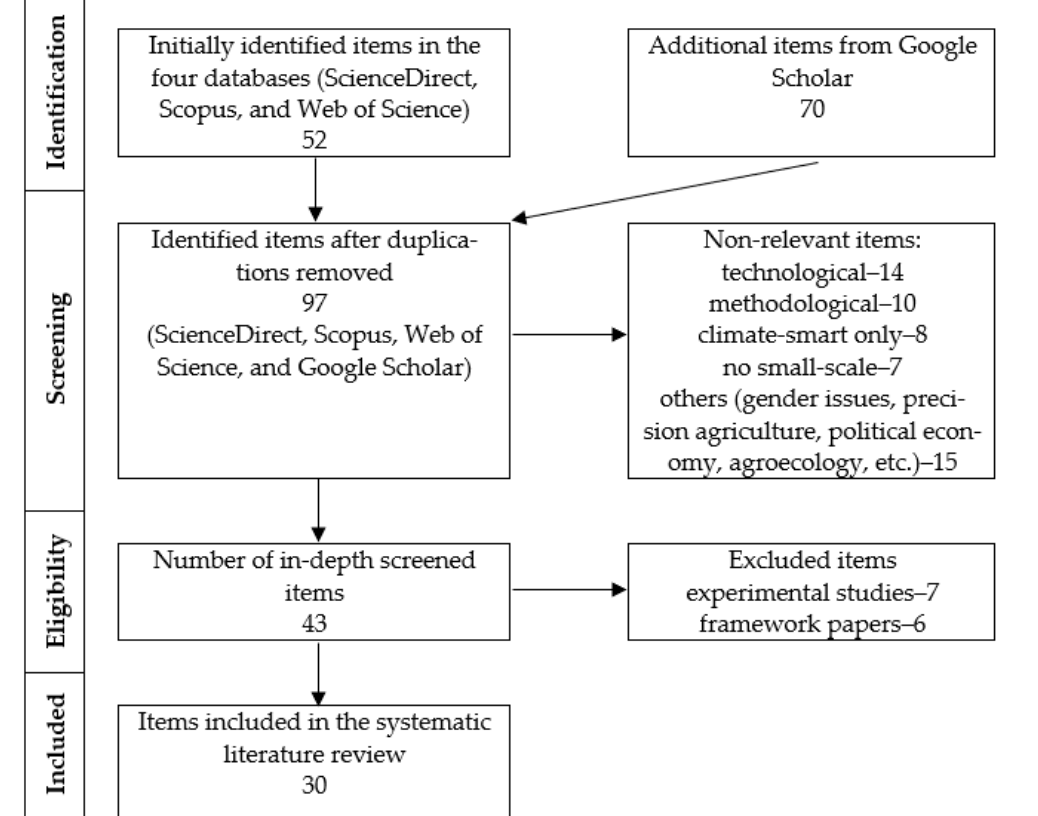
Figure 3. Flowchart of the literature selection process.